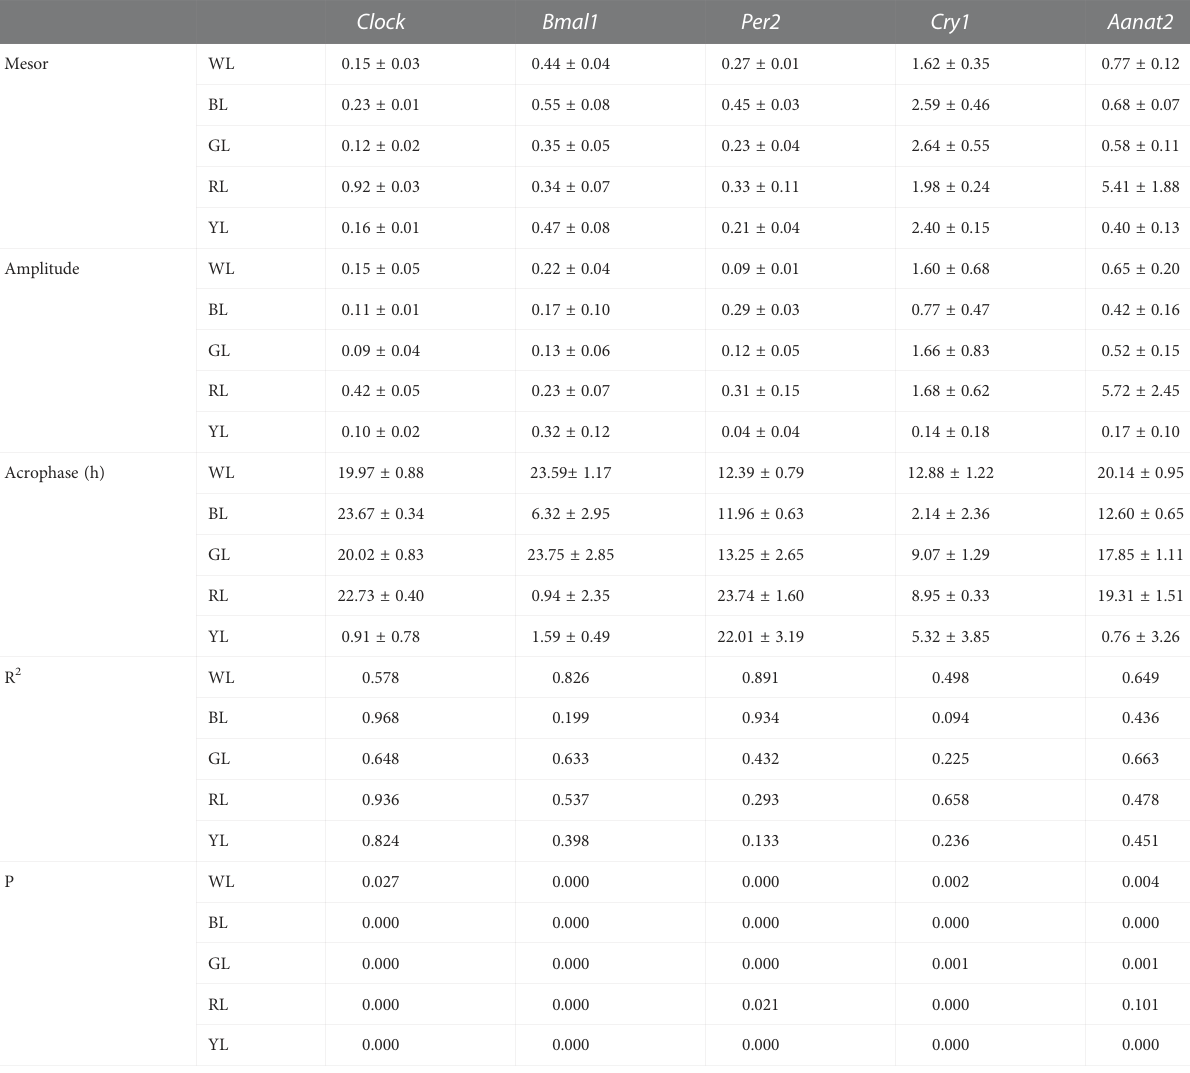
TABLE 2 Rhythm parameters (mean ± SEM) of clock genes and Aanat2 in brain under different light treatments.